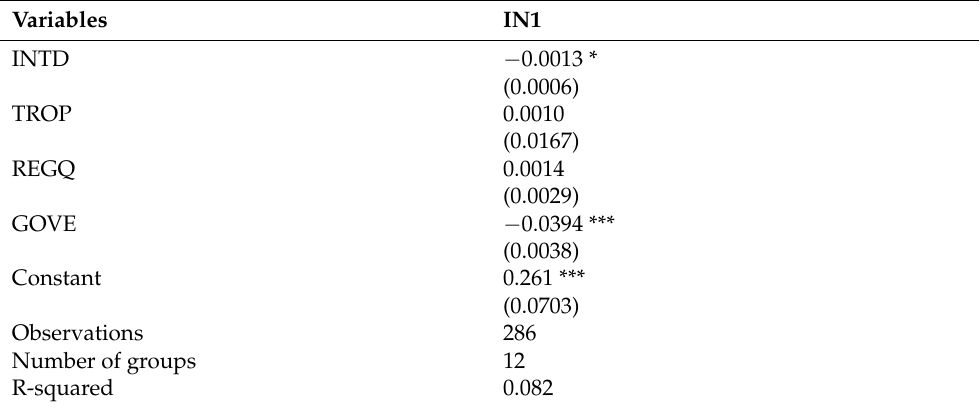
Table 16. Model 6. Income Share of the Top 1% (IN1).